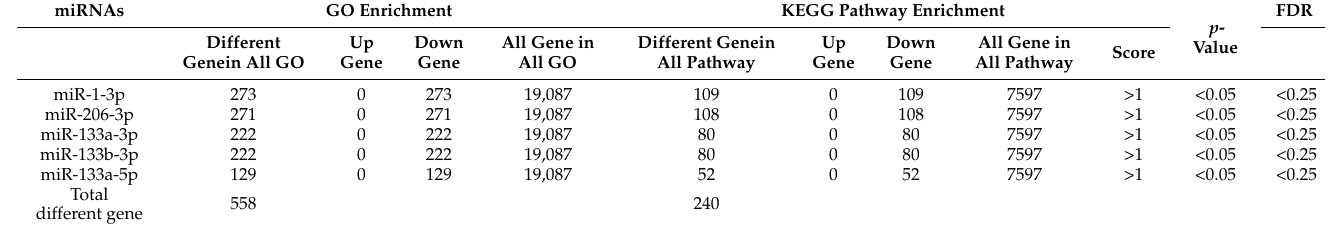
Table 3. GO and KEGG enrichment analysis results of target genes of differently expressed miRNAs